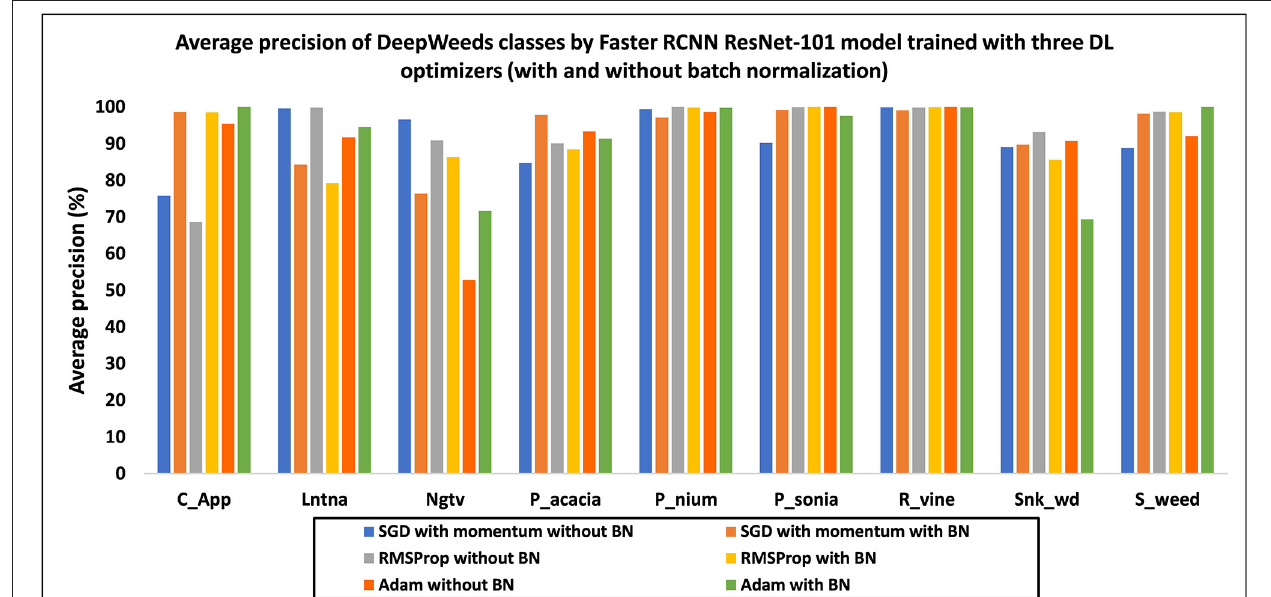
FIGURE 11 | Average precision of each class by the Faster RCNN ResNet-101 model trained with three DL optimizers in the absence and presence of batch normalization. as compared to the default settings and it proved the effectiveness of the weed detection pipeline presented in this